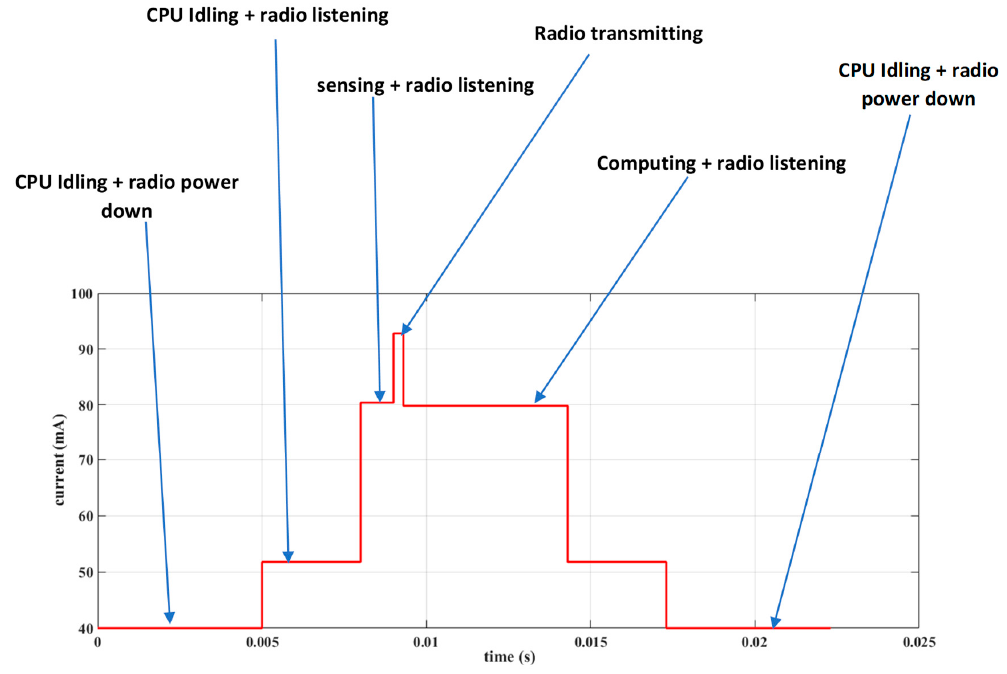
Figure 13. Sensor node’s current profile from simulation.